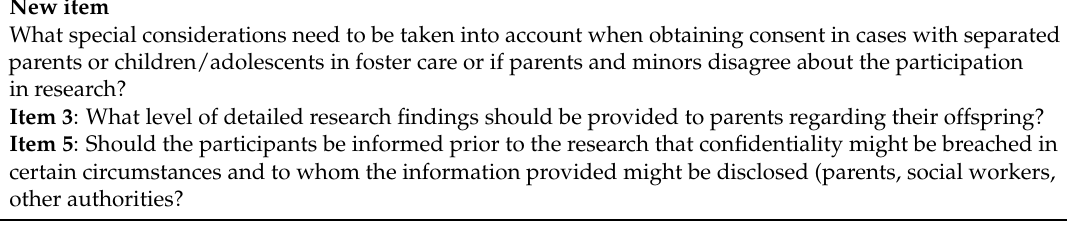
Table 2. List of Ethical Issues of researchers